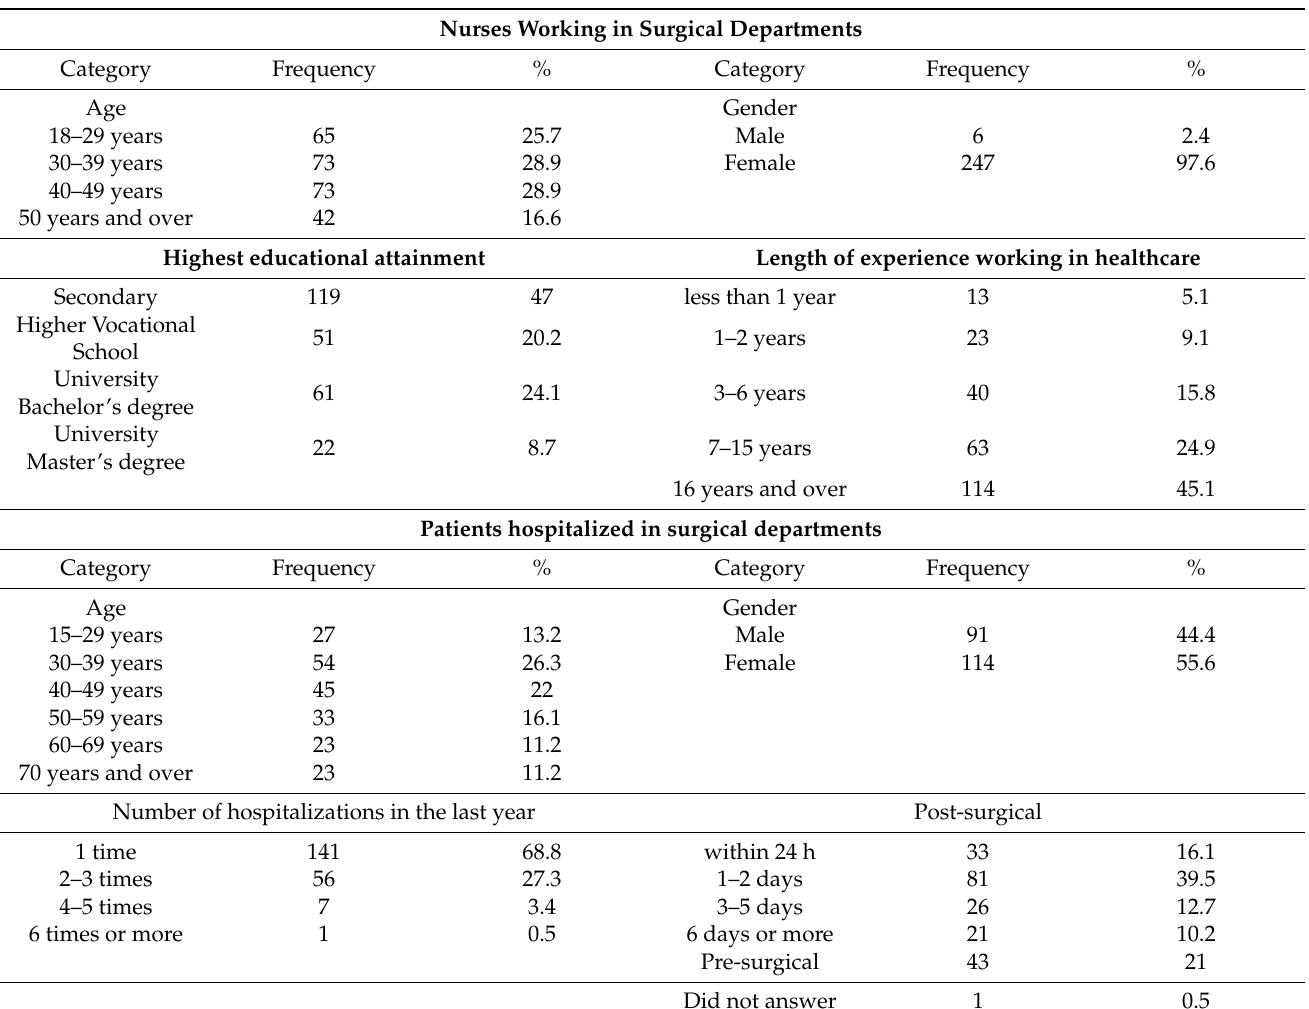
Table 1. Characteristics of the study